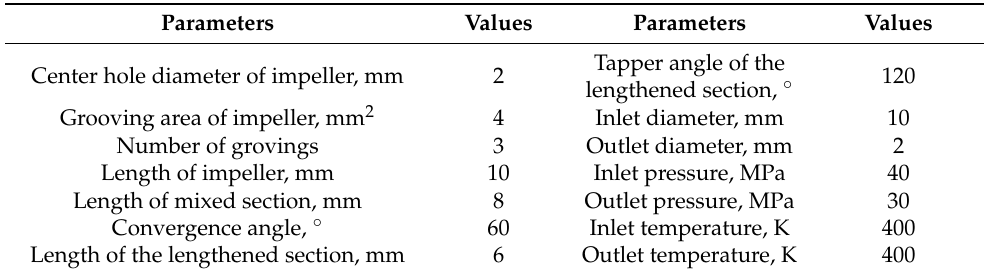
Table 1. Structure parameters of nozzle. Parameters Values Parameters